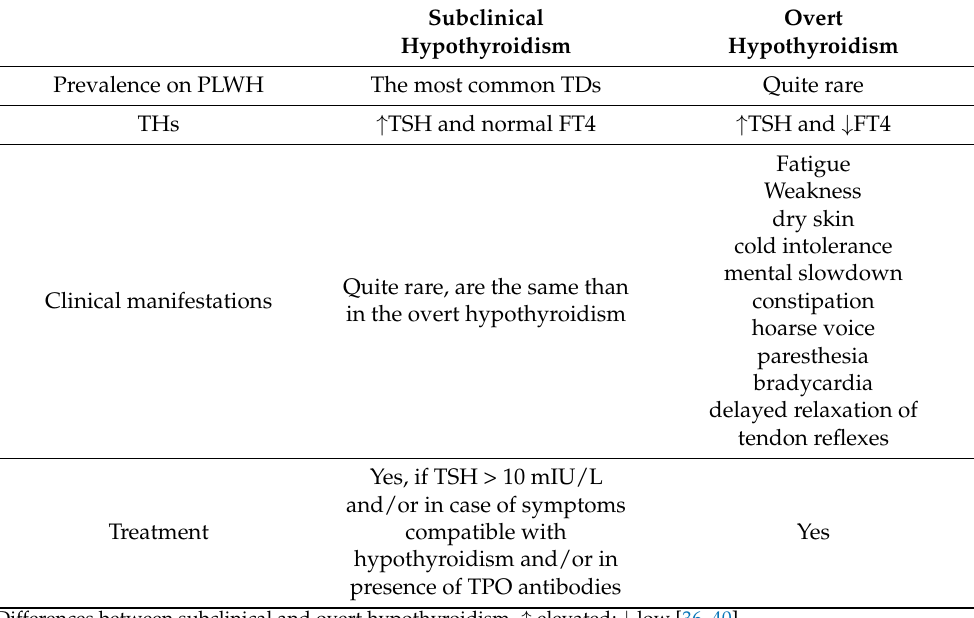
Table 1. Main differences between subclinical and overt